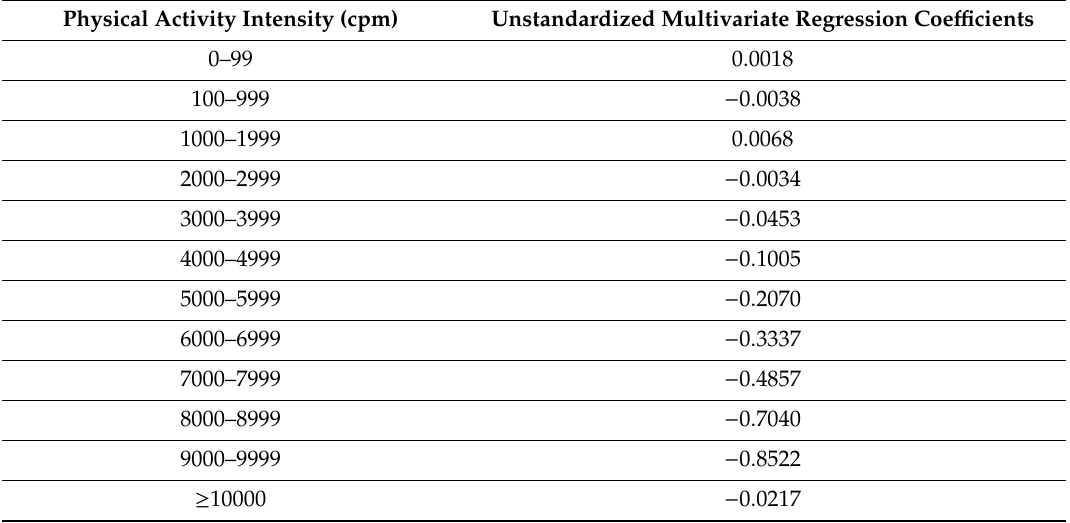
Table 2. Regression coe ffi cients (unstandardized) obtained from the multivariate pattern analysis. Physical Activity Intensity (cpm)